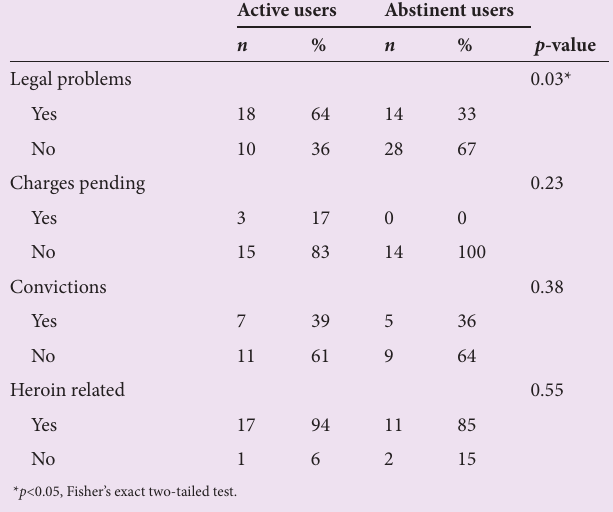
Table 2. Forensic data of active heroin users v. abstinent users during the four years after admission for heroin detoxification at the Opioid Doxification Unit at Stikland